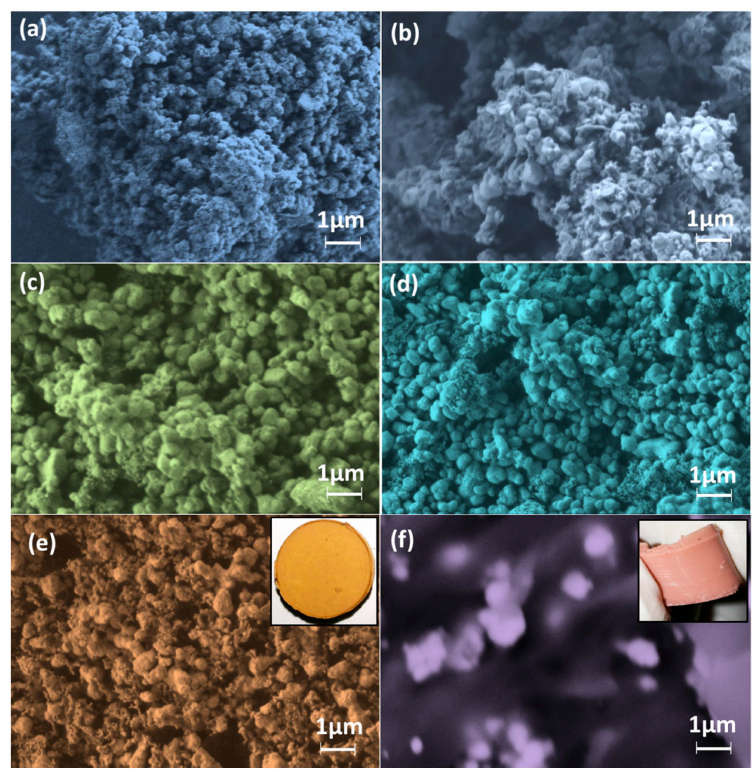
Figure 4. Field emission scanning electron microscope (FESEM) images of the ( a ) unsintered; ( b ) S450; ( c ) S650; ( d ) S850; and ( e ) S1050 ceramics samples; and ( f ) S1050/PDMS composite film. Note: the insets in images ( e , f ) are the tested pallet of S1050 and S1050/PDMS film,